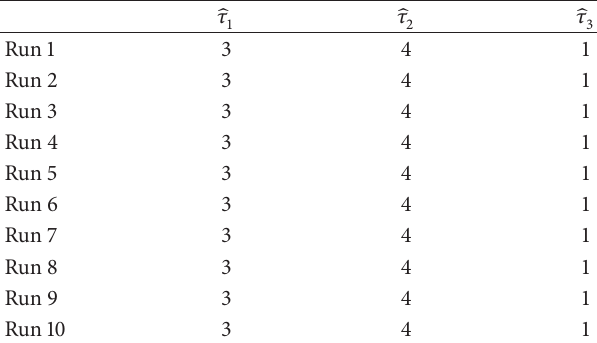
Table 2: Estimation results for Example